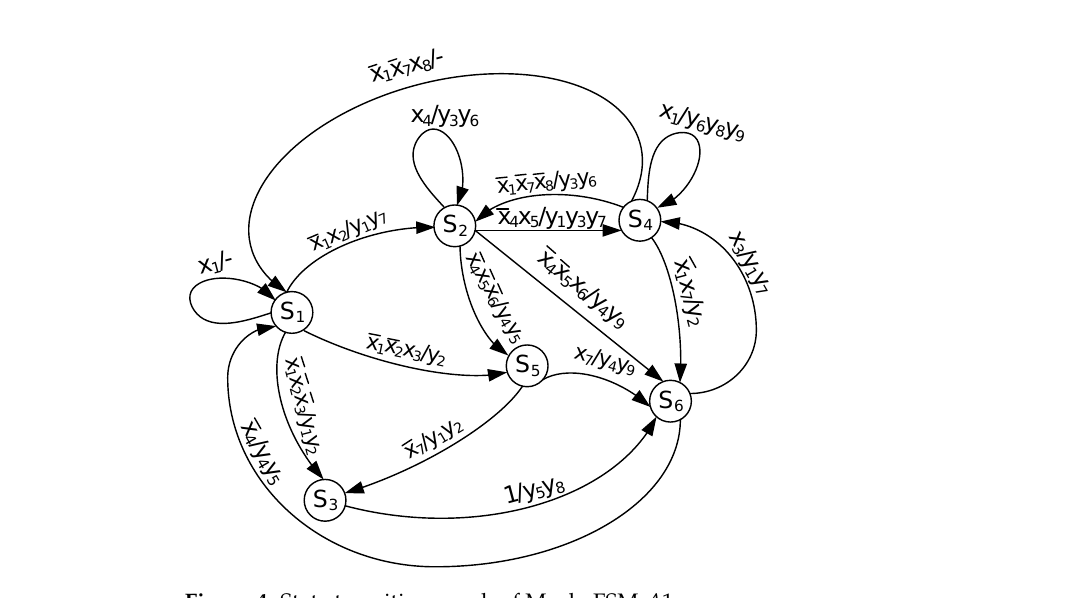
Figure 4. State transition graph of Mealy FSM A 1. Table 1. State transition table of FSM A